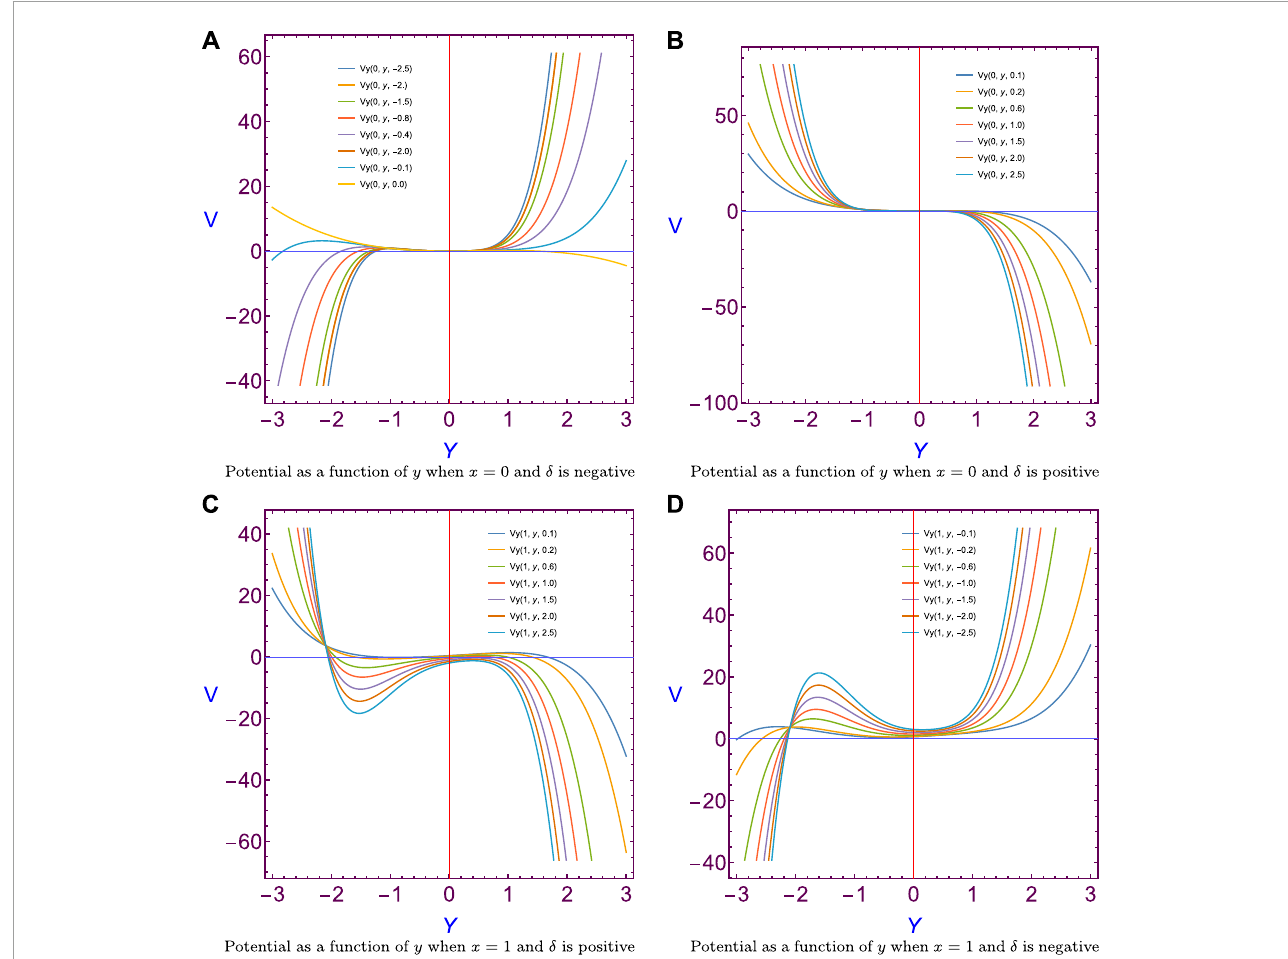
FIGURE 3 Hénon–Heiles potential for different values of transition parameter δ when x is constant.